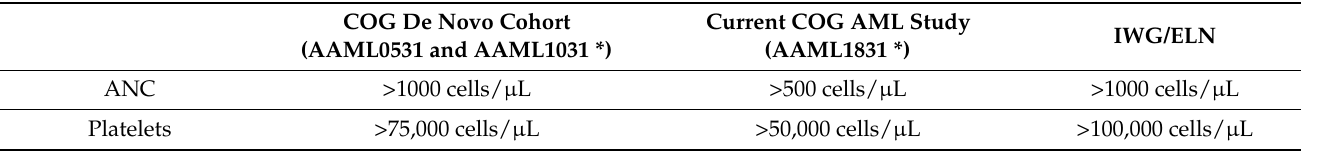
Table Legend: * AAML0531 (NCT00372593), AAML1031 (NCT01371981), AAML1831 (NCT04293562); Abbrevia- tions: AML, acute myeloid leukemia; ANC, absolute neutrophil count; COG, Children’s Oncology Group; ELN, European LeukemiaNet; IWG, International Working